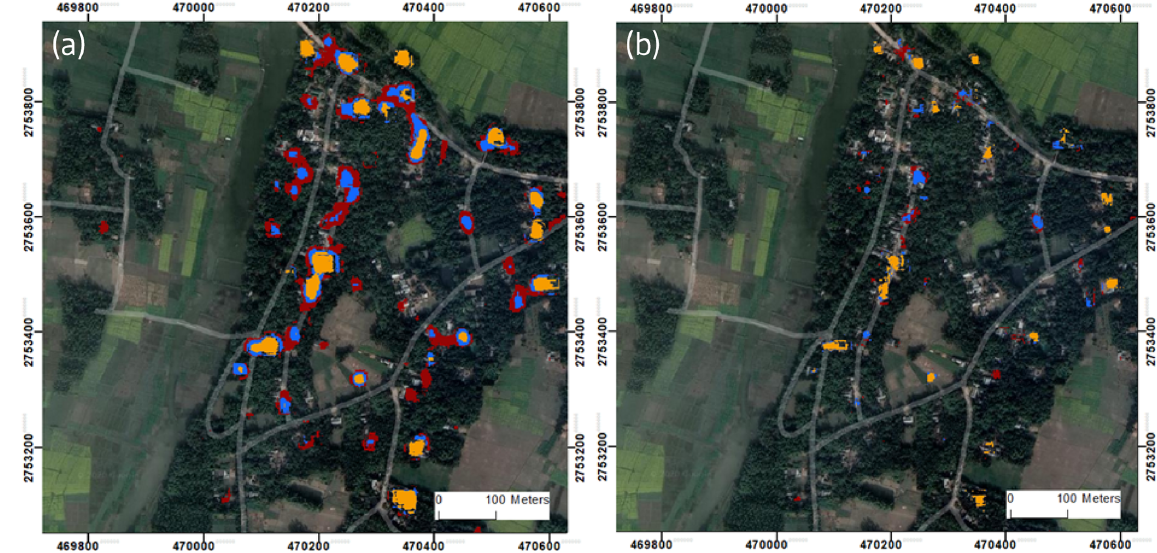
Figure 7. Influence of classification thresholds on settlement detection. Shown are dispersion index thresholds of 0.4 (a) and 0.25 (b) – the lower the threshold, the more stable a pixel has to be for it to be classified as a PS candidate. Colors correspond to different values of the amplitude threshold: − 4dB (red), − 2dB (blue) and 0dB (orange) – the lower the threshold, the higher the chance of classifying tree pixels as settlement pixels. Source of optical background image: Google, ©2020 Maxar Technologies, CNES/Airbus. Table 2. Accuracy assessment of the SAR-based classification for 2 months. Indicated are the accuracy values averaged for November/March over 3 consecutive years. Month Class User’s accuracy Producer’s accuracy Overall